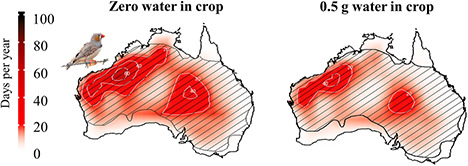
Average number of days per year with conditions associated with a moderate lethal dehydration risk (i.e. survival time <5 hr) for zebra finches (T. guttata) across Australia under recent climatic conditions (2000–2010 CE) for birds that are fully hydrated with no water or food stored in their crop at the onset of the period of inactivity on a very hot day (left) and birds whose crops are full of water (right). Species ranges illustrated by cross-hatching. Bird images courtesy of the Macaulay Library at the Cornell Lab of Ornithology [Photographer: Chris Wiley (ML38358341)].